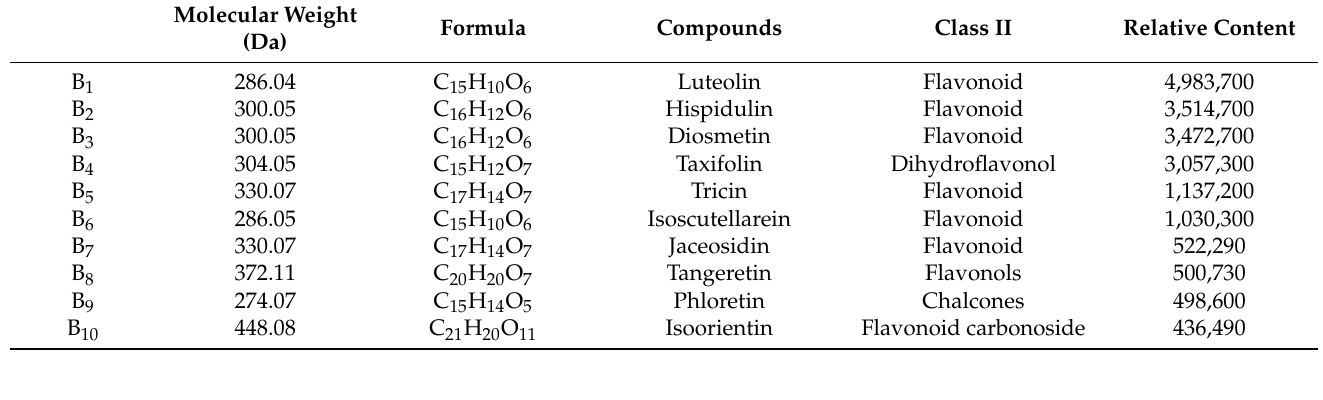
Table 2. The relative content of major flavonoid aglycones.